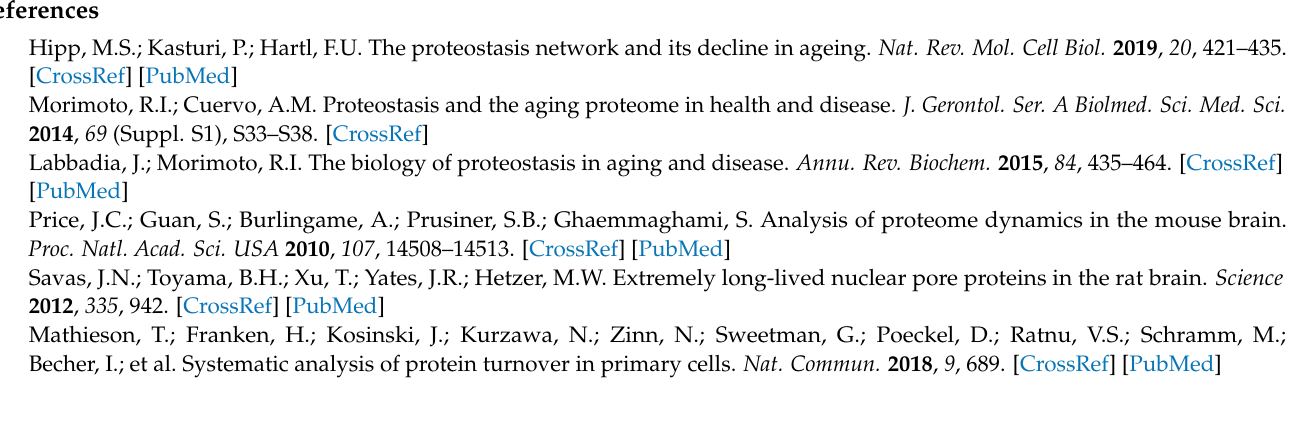
Supplementary Figure S2: Original western blot images used for main Figure 5. Supplementary Figure S3: Correlations of protein half-lives with biochemical properties including or excluding SNAP-tag. Supplementary Table S1: Summary of DNA sequences. Note that all plasmids are available upon reasonable request. Supplementary Table S2: List of primary degrons from [21] and protein sequences of the turnover sensors. No primary degrons were found in the sequences of our